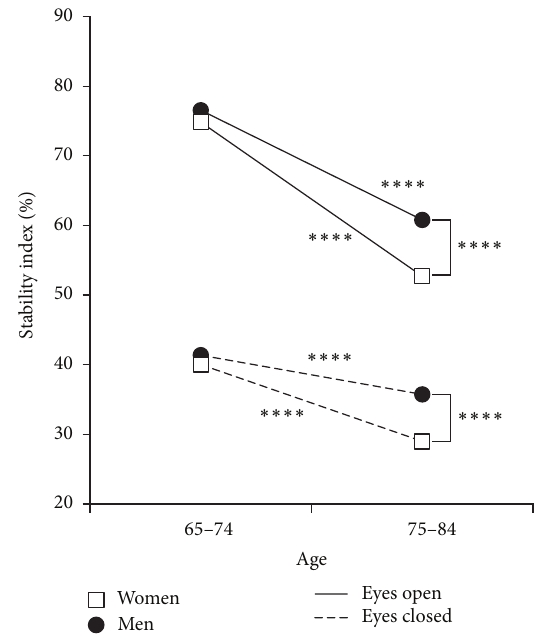
Figure 2: Single stance test: Stability index in men and women according to age. Values of stability index in eyes closed (indicator ofproprioceptivecontrol)andeyesopen(allsensorychannelsopen) conditions; ∗∗∗∗ 𝑃 < 0.001